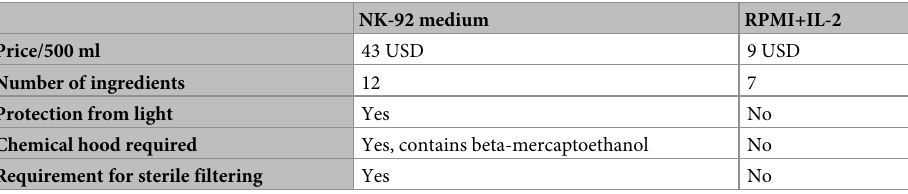
Table 2. Features of the different media used in this